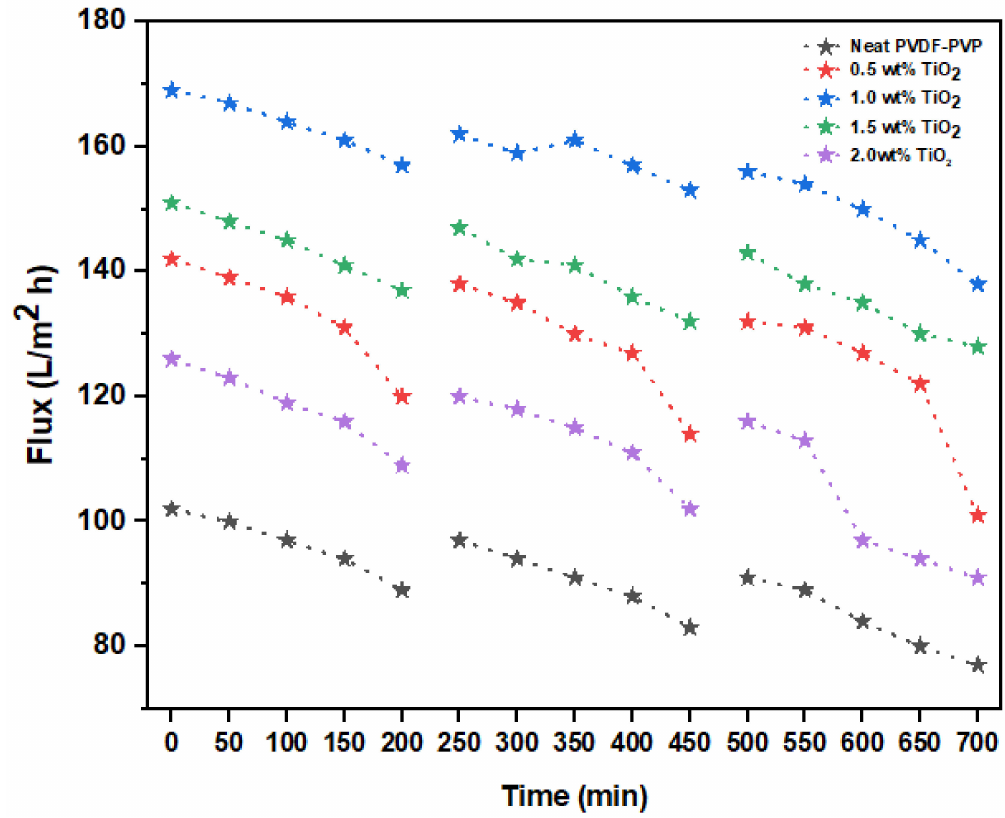
Figure 8. Antifouling characteristics of neat and modified membranes (0.5, 1.0, 1.5, and 2.0 wt% TiO 2